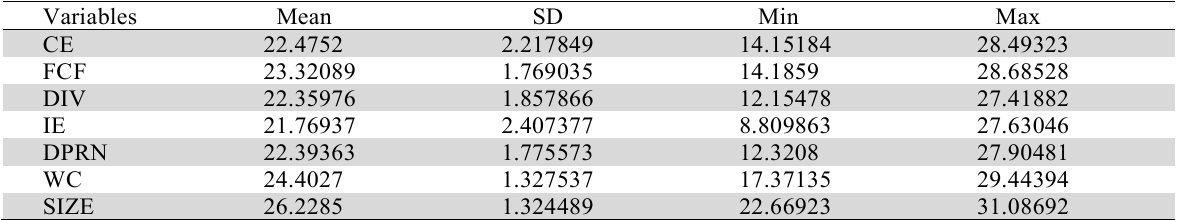
Descriptive statistics of research variables ( Unit: